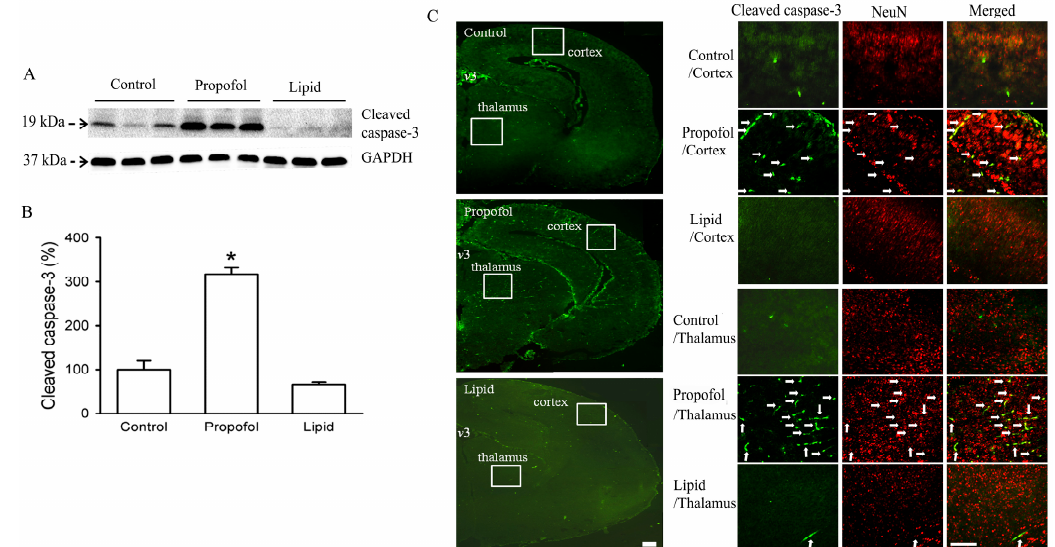
Figure 1. Propofol anesthesia for 1 h in pregnant rats induces caspase-3 activation in the brain tissues of fetal rats within 6 h. Propofol general anesthesia or intralipid (IV, 1 h) was administered to pregnant rats at the age of gestational days 20. After six hours, fetuses were removed, and fetal brain tissues were harvested and analyzed by Western blot . ( A , B ) Western blot data of cleaved caspase-3 in the fetal brain tissues exposed to propofol in utero and control condition (* p < 0.001, n = 4 fetuses/group); ( C ) Representative photomicrographs of the distribution of activated caspase-3-positive cells in the fetal brain tissues exposed to propofol in utero and control condition. There are sparse activated caspase-3-positive cells in the control fetal brain. However, activated caspase-3-positive neuronal profiles were abundant and heavily concentrated in regions such as the frontal cortex and thalamus in the fetal brains exposed to propofol. Double staining with antibody to cleaved caspase-3 ( green ) and antibody to NeuN, a neuron-specific nuclear protein ( red ), demonstrated that most of the cleaved caspase-3 positive cells were neurons ( white arrows). v 3, third ventricle. The small squares outlined in white in the right panel indicate the regions shown at higher magnification in the left panel. Scale bar = 100 µm in right panel; scale bar = 50 µm in left panel [36].